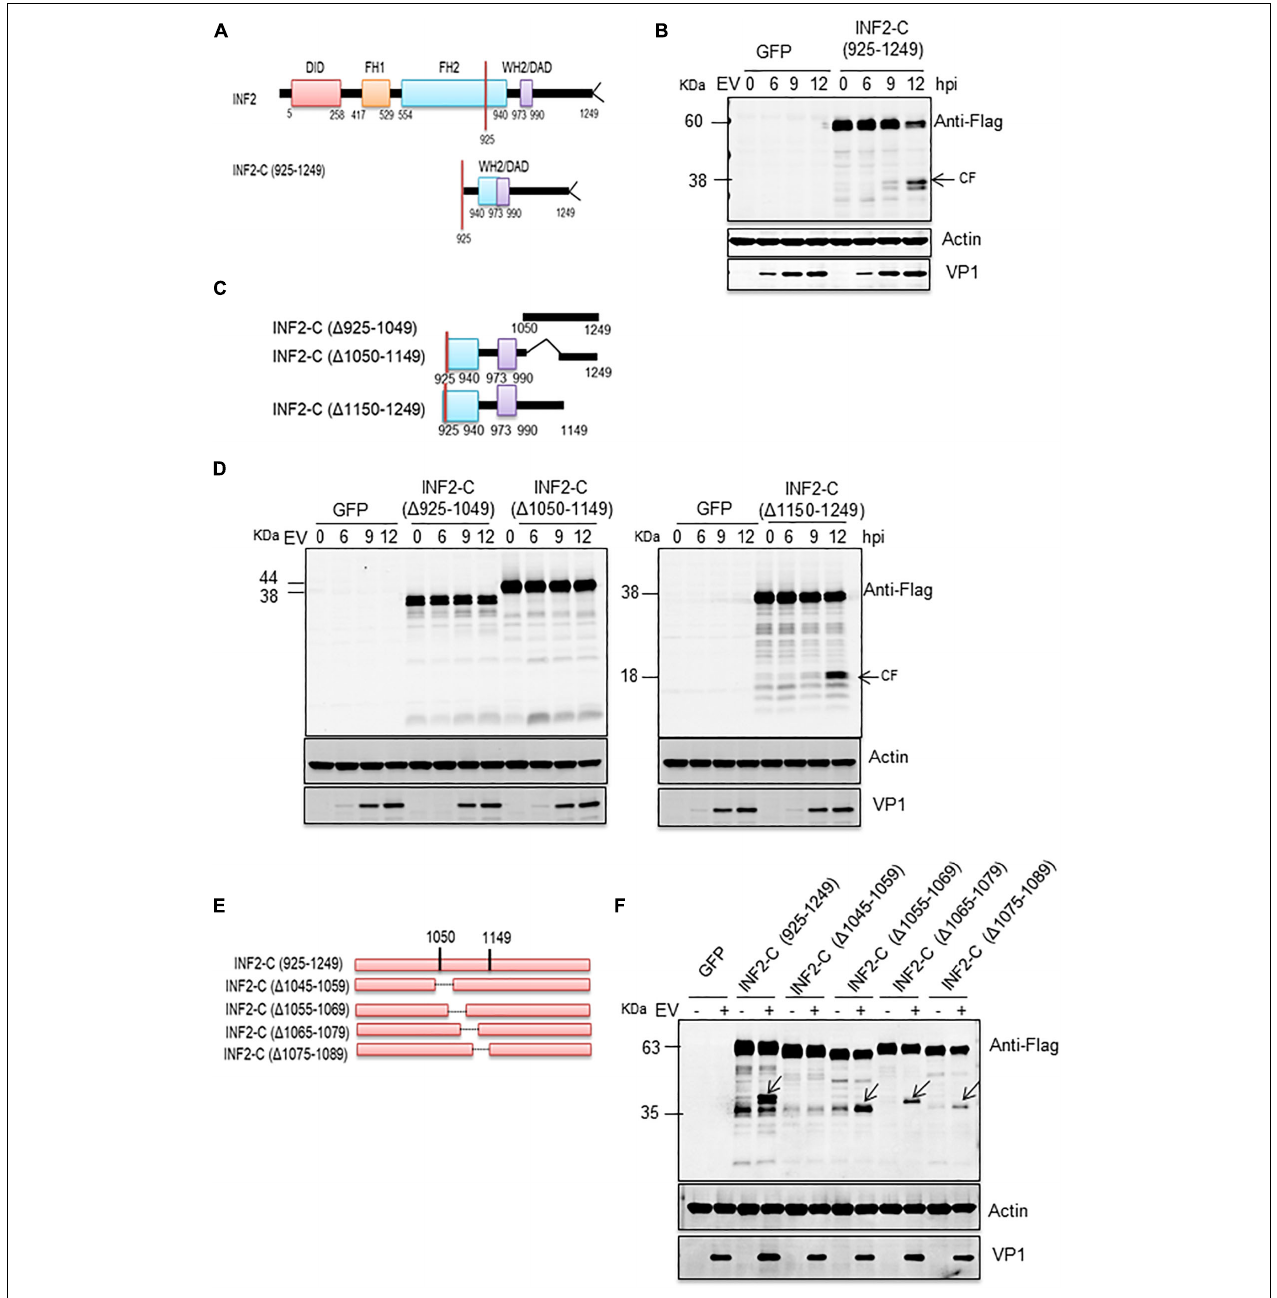
FIGURE 3 | EV71-induced INF2 cleavage is located at the 1,045–1,059 amino acid region of INF2. (A) Schematic diagram of the INF2 structural domains. (B) RD cells were transfected with plasmids encoding GFP control or INF2-C (925–1,249), 24 h after transfection, the cells were infected with EV71 (MOI = 10) for the indicated times (hpi, h post-infection), and then the cells were harvested, and Western blot was performed using the indicated antibodies. Arrows indicate the cleavage fragments (CF). (C) Schematic diagram of deletion mutants sued in (D) . (D) RD cells were transfected with plasmids encoding the GFP control, INF2-C ( (cid:49) 925–1,049), INF2-C ( (cid:49) 1,050–1,149), and INF2-C ( (cid:49) 1,150–1,249); then the cells were be treated as described in (B) . (E) Schematic diagram of deletion mutants sued in (F) . (F) RD cells were transfected with plasmids GFP control and indicated deletion mutants. The cells were then treated as described in (B)